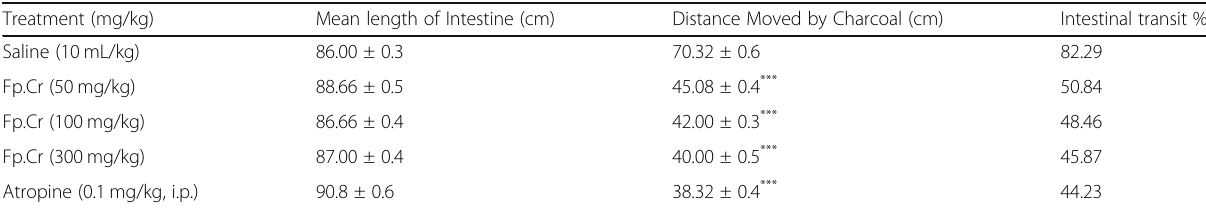
Table 3 Effect of Ficus palmata crude extract (Fp.Cr) and atropine on charcoal meal transit time in rats Treatment (mg/kg) Mean length of Intestine (cm) Distance Moved by Charcoal